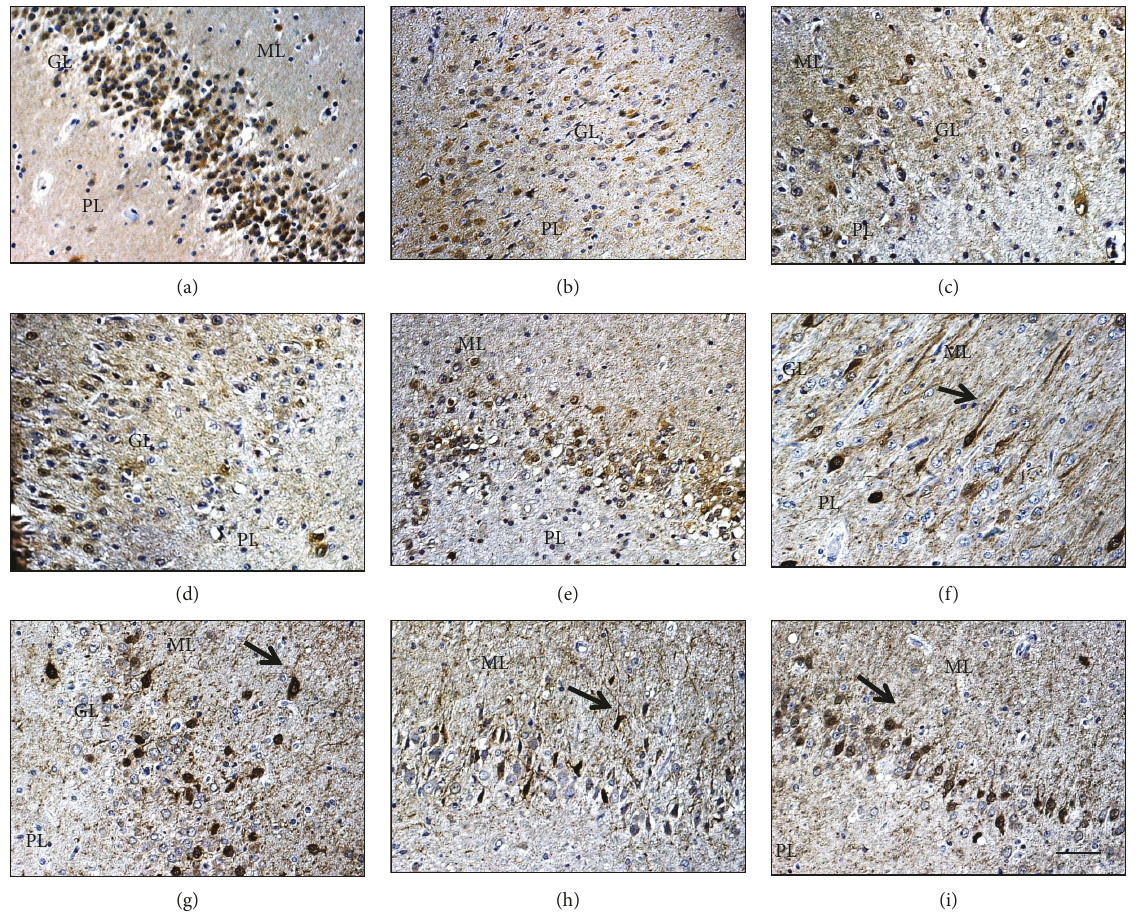
Figure 2: Hippocampal sections from postmortem control (a) and TLE with HS (b – i). PL: polymorphic layer; ML: molecular layer; GL: granular cell layer. (a) Qualitative analysis of postmortem control shows homogeneous CB+ granular cell morphology and staining and the absence of GL dispersion and/or ectopic localization. (b – e) Qualitative examination of dentate gyrus sections from TLE patients showed lower CB+ cell density among all dentate gyri (cases 5, 6, 14, and 15 of Table 1). (f – i) Qualitative examination of dentate gyrus sections from TLE+D patients showed a pattern with a reduced number of CB+ granular cells predominantly among basal layers (basal granule cells are predominantly CB negative), with a great proportion of strong CB+ cells located in outer layers, with CB-positive arborization (CB+ sprouted cells), ectopic localization (inner molecular layers), higher CB+ content (higher staining intensity and CB+ area), and longer apical CB+ sprouted fi bers projecting into ML (arrows). Basal CB+ sprouted processes are also observed (cases 20, 21, 23, and 24 of Table 1). Magni fi cation (20x), scale bar 30 μ